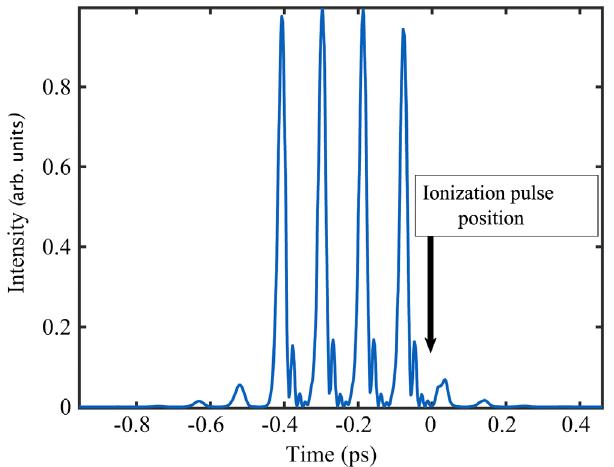
FIG. 2. The intensity profile of the train of 30 fs long pulses generated with the TEMPI technique. The train moves through the left. The pulse-to-pulse delay is close to the resonant plasma period. Note the presence of low intensity prepulses and post- pulses due to imperfections in pulse(s) compression. The high intensity pulses possess a structured train of low intensity ripples (of about 20% of the peak intensity) caused by nonlinear effects during the pulses